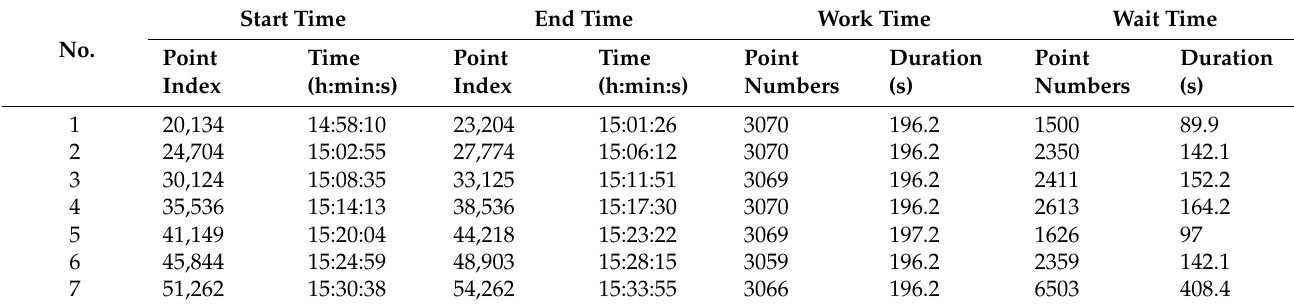
Table 4. Real-time monitoring results.